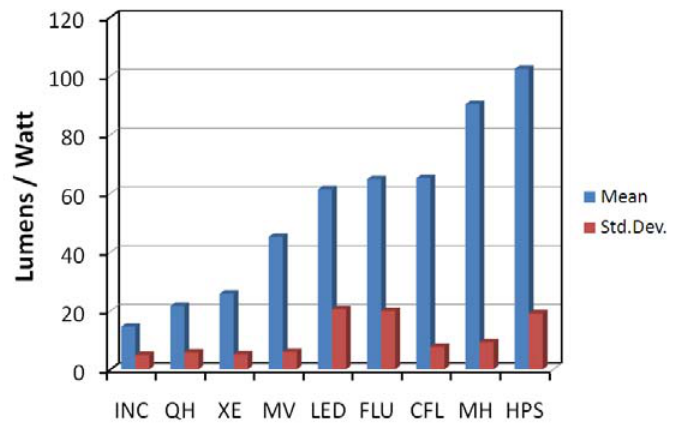
Figure 27. Mean and standard deviation for luminous efficacies calculated for a wide range of lamps derived from manufacturer data. INC = incandescant, QH = quartz halogen, XE = xenon arc, MV = mercury vapor, LED = light emitting diode, FLU = linear fluorescent, CFL = compact fluorescent, MH = metal halide, HPS = high pressure